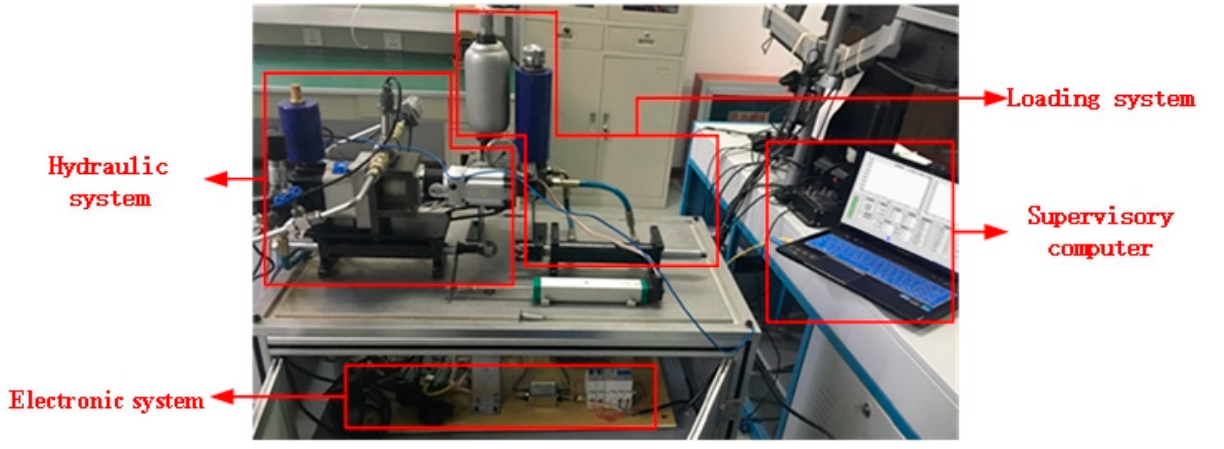
Figure 11. Hydraulic system and supervisory computer.